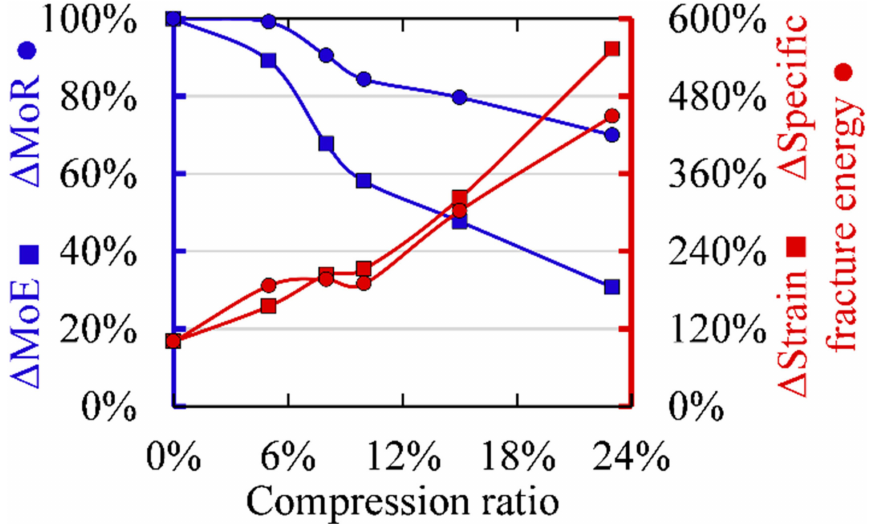
Figure 13. Relative results of a 3-point bend test as a function of beech species with different compression ratios. Numerical test results from [74] were used to plot the graph, reproduced from [59] with permission from B á der, 2023. Abbreviations: ∆ Strain—change of the strain at the moment of the greatest bending stress; ∆ MoR—change of the modulus of rupture; ∆ MoE—change of the modulus of